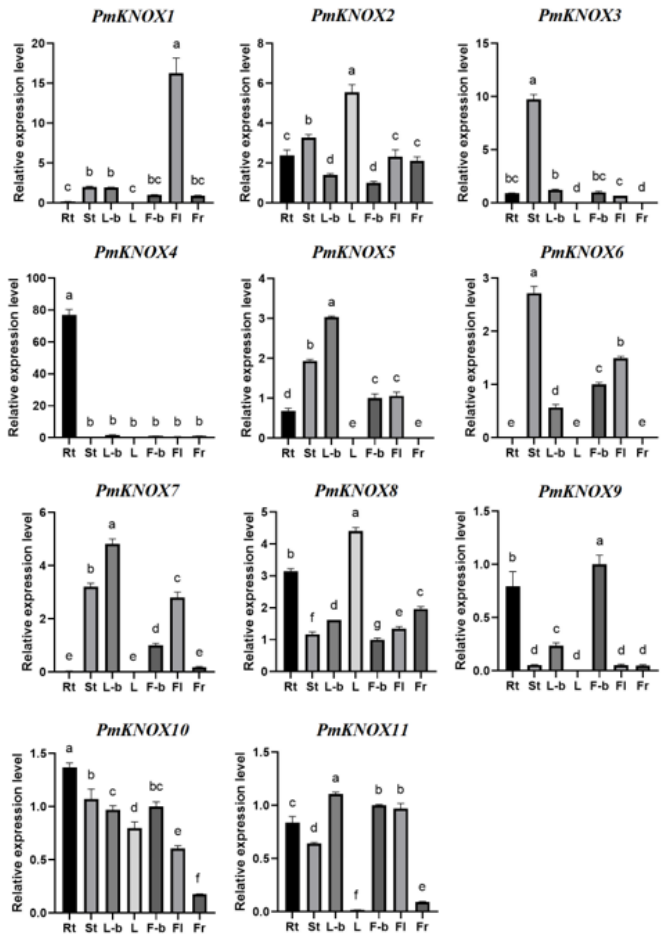
Figure 5. Expression analysis of the PmKNOX genes in different tissues. Rt for root, St for the stem, L for leaf, L-b for leaf bud, F-b for fl ower bud, Fl for fl ower and Fr for fruit. The le tt er indicates a signi fi cant change in the variance analysis ( p < 0.05).